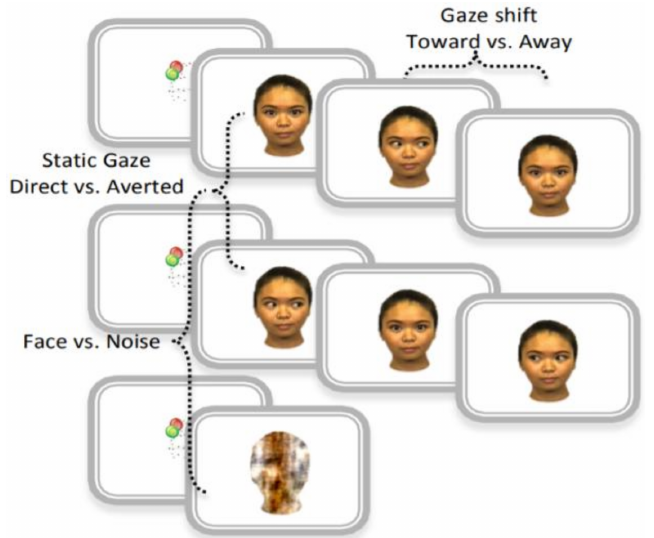
Figure 1. Event-related potential (ERP) task corresponding to visual stimulus used in the original study: static gaze—direct and averted. Face and noise—gaze shift toward and away- Reprinted from ref. [6] (Supplemental Data Section Figure